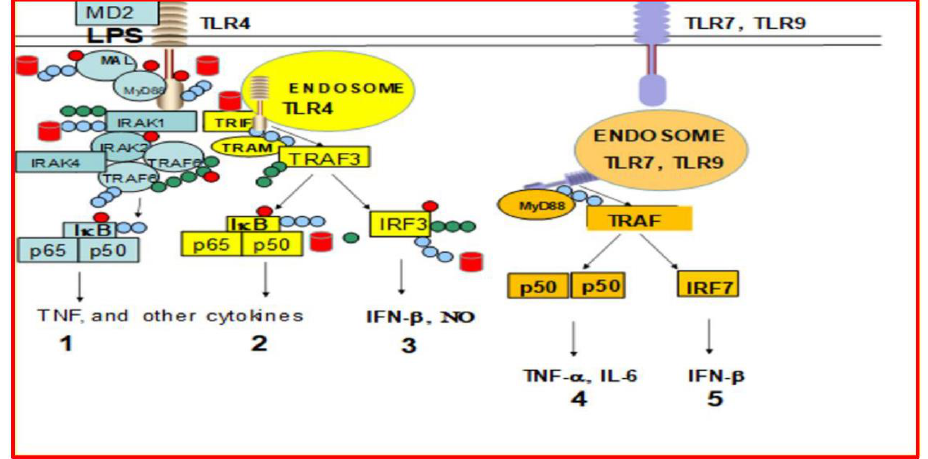
Figure 3. LPS-Signaling pathways. LPS signals via TLR4 (pathways 1 – 3). There are several mediators that are degraded by the proteasome such as MAL, IRAK1, TRAF6, IRF3, and IκB - α. The blue chains represent the K48-linked ubiquitins and those proteins are destined to be degraded by the proteasome [13]. The green chains in contrast, represent the K63-linked chains, which when linked to mediators have regulatory functions like TRAF6. The red circles represent phosphoryl groups, and the red barrels represent the proteasomes. Thus, proteasomes can regulate the degradation of signaling mediator proteins and can also activate transcription factors like NF- κB, IRF3, and IRF7 thus affecting gene expression of proteins. Thus, the proteasomes can regulate the degradation of proteins and synthesis of newly formed proteins.